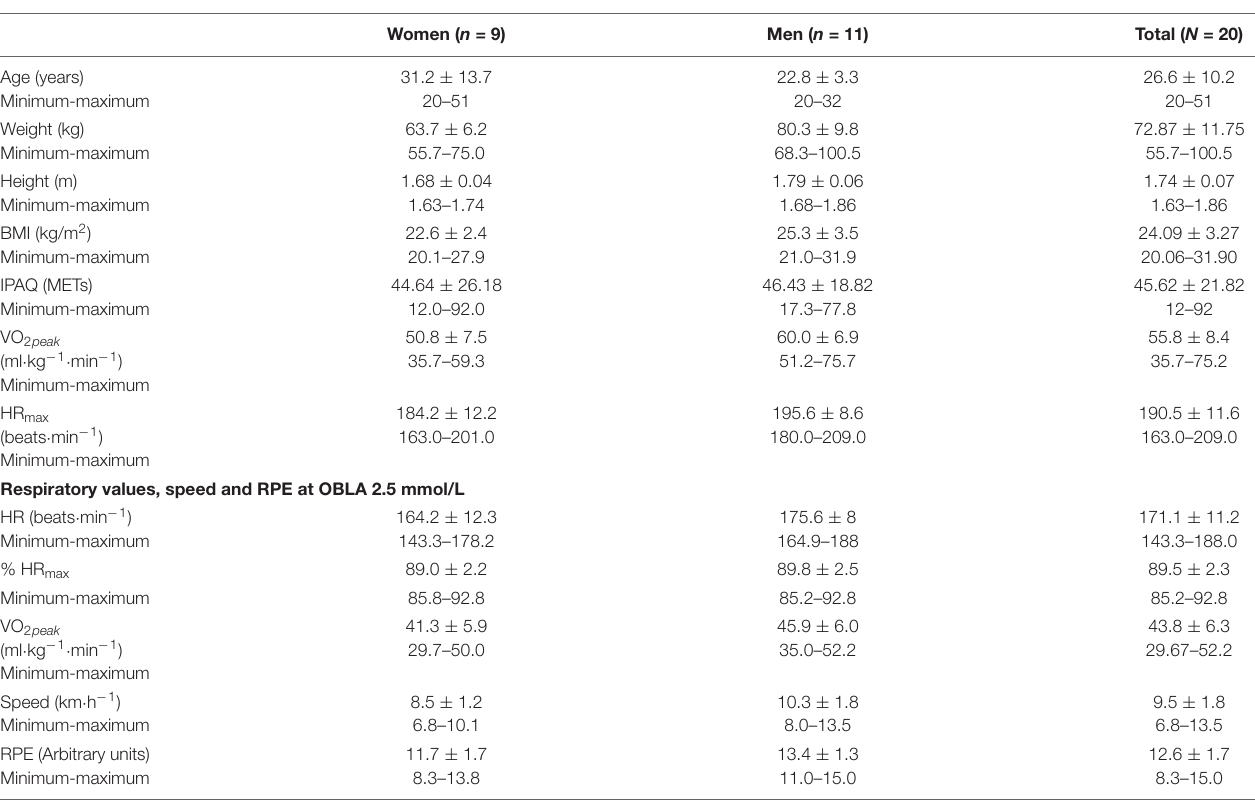
TABLE 1 | Descriptive